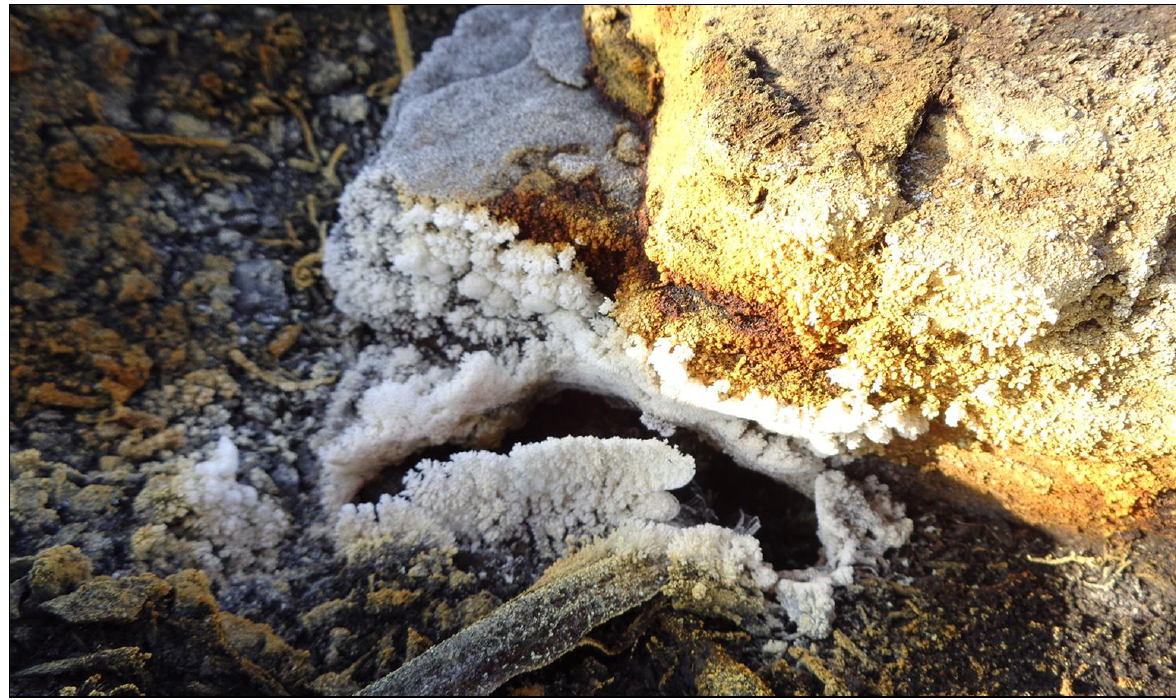
Fig. 3. Sulphur efflorescence on the surface of the "Wojkowice" spoil tip, January 2017 ( A. Zarychta )